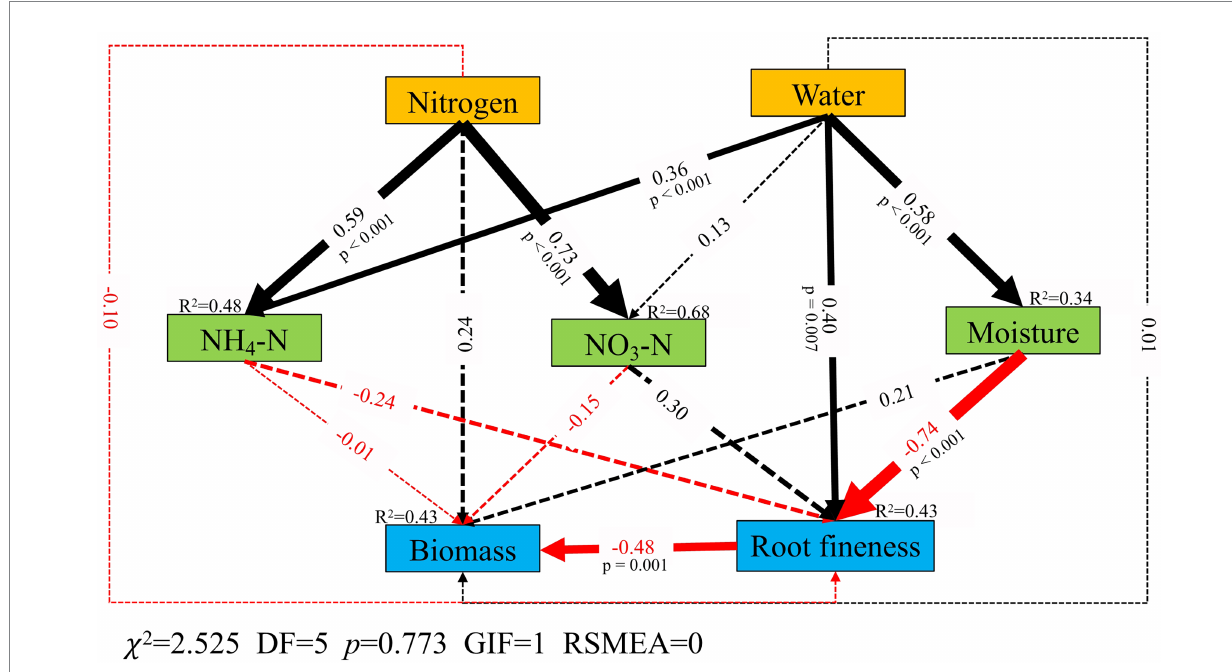
FIGURE 4 Structural-equation model (SEM) analysis of the influence pathways of canopy addition of N and water on fine root biomass and root fineness (include specific root length, specific root area, root tissue density, root tip density, root branching density, specific root tip density and specific branching density). The model fitting data are shown in the lower left corner of the pathway figure (a high p value associated with the χ 2 test indicates a good fit of the model to the data, i.e., no significant discrepancies; DF, degrees of freedom; RMSEA, root mean squared error of approximation). The solid lines represent significant relationships ( p < 0.05), and the dashed lines represent non-significant relationships ( p > 0.05). The black arrows represent positive effects, and the red arrows represent negative effects. Values associated with the arrows and their width represent standardized path coefficients. R 2 values associated with the response variables indicate the proportion of variation explained by relationships with other